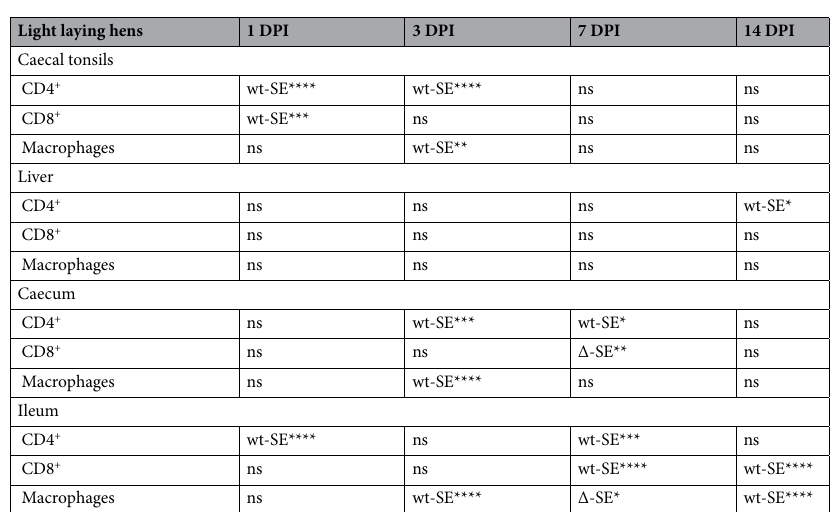
Table 3. Representation of the significant difference related to the quantitative distribution of different immune response cells in organs of light laying hens infected with Salmonella Enteritidis wild and mutant strains at different days post-infection. DPI, days post-infection; ∆-SE, Salmonella Enteritidis ∆ ttr A∆ pdu A; wt-SE, Salmonella Enteritidis wild-type; ns, no significant difference. Within each organ and DPI, * means difference by two-way ANOVA followed by Bonferroni’s comparison test between wild and mutant strains values (*P ≤ 0.05; **P ≤ 0.01; ***P ≤ 0.001; ****P ≤ 0.0001). The strain presented in the table (∆-SE or wt-SE) as significant within the organ and DPI is that shown the major infiltration area to each